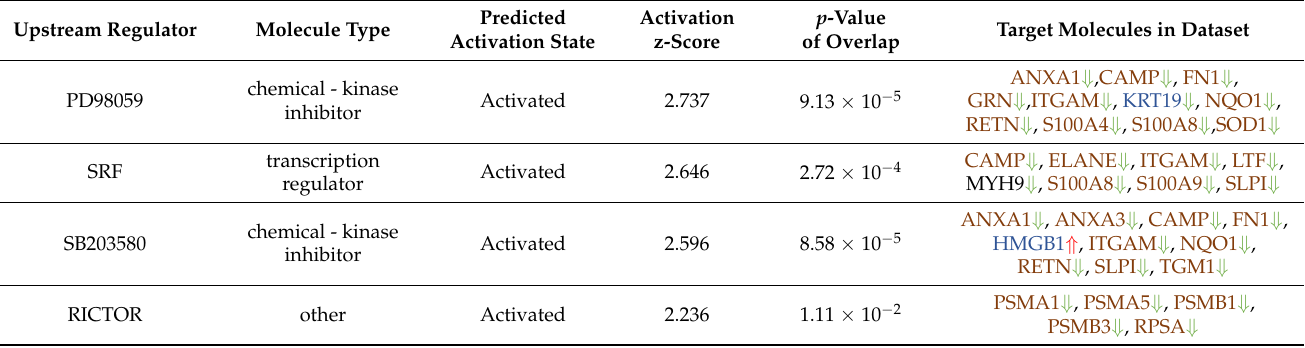
Table 2. Upstream regulators identified using information from the Ingenuity Pathway Analysis (IPA) software (Qia- gen,